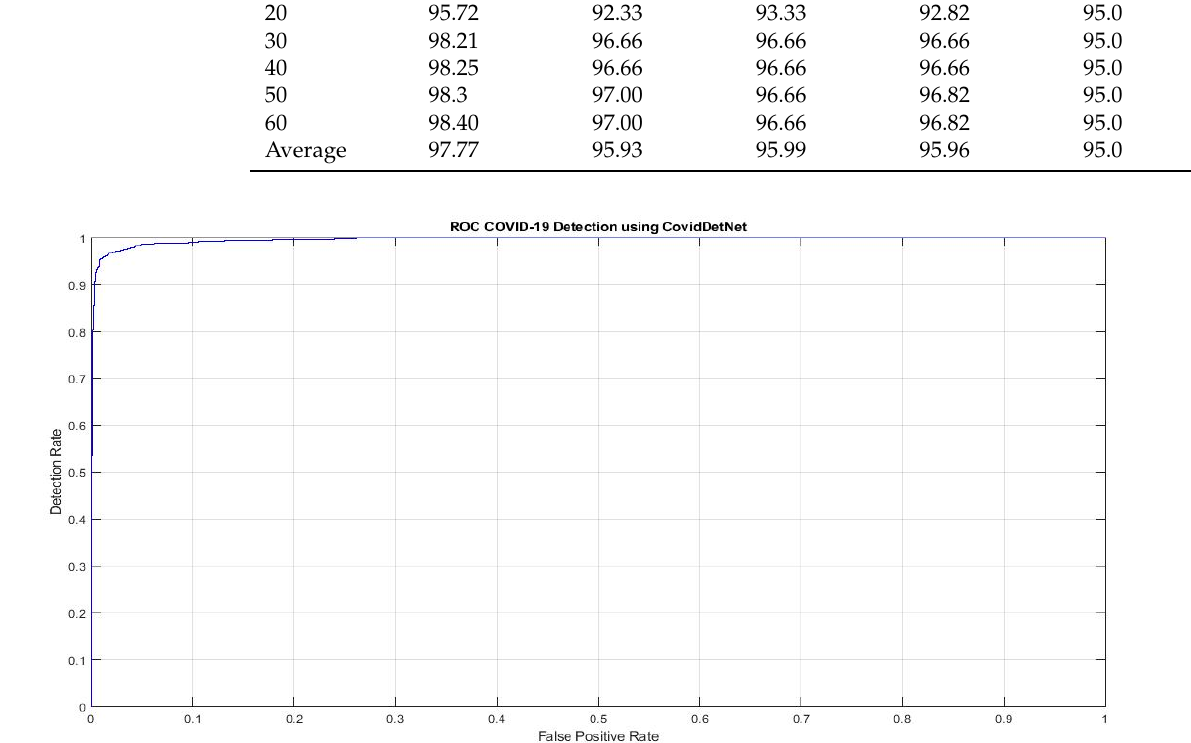
Figure 6. ROC of CovidDetNet framework for COVID-19 detection, the y-axis represents true-positive rate and false-positive rate.